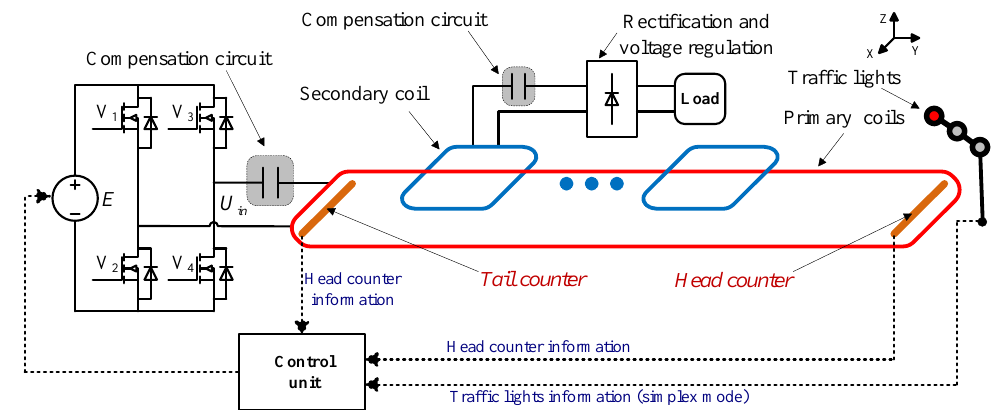
Figure 2. The structure diagram of the opportunity EV wireless charging system.